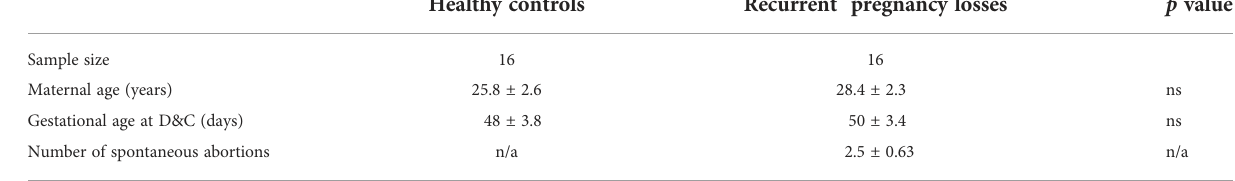
TABLE 1 Clinical characteristics of the recruited